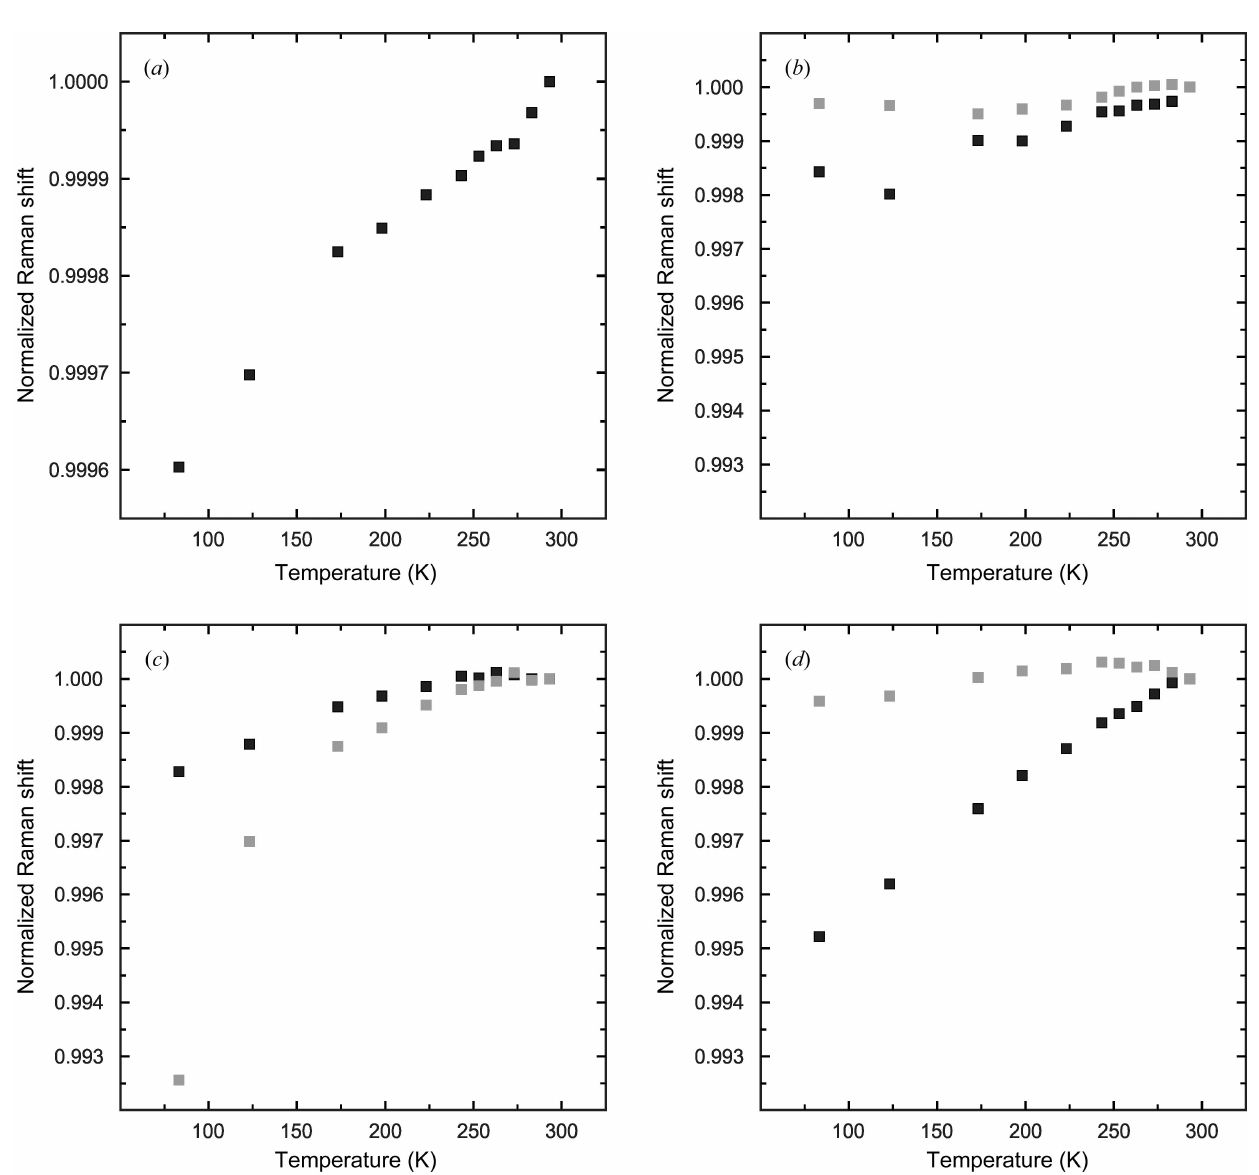
Figure 3 Raman shift of the bands assigned to the individual guest molecules and their evolution with decreasing T (relative to RT): ( a ) CH 4 , ( b ) C 2 H 6 , ( c ) C 3 H 8 and ( d ) i -C 4 H 10 . Black squares correspond to the bands assigned to the [5 12 ] cage, gray squares to those of the [5 12 6 4 ] cage. The ESDs are smaller than the symbol size.